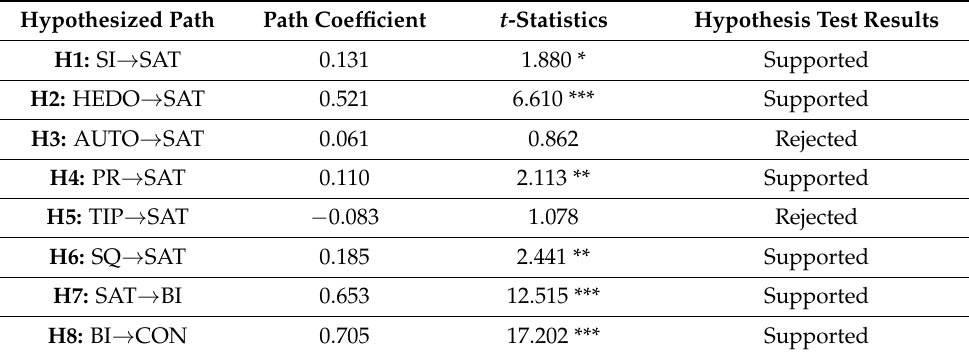
Table 3. Results of the hypothesis